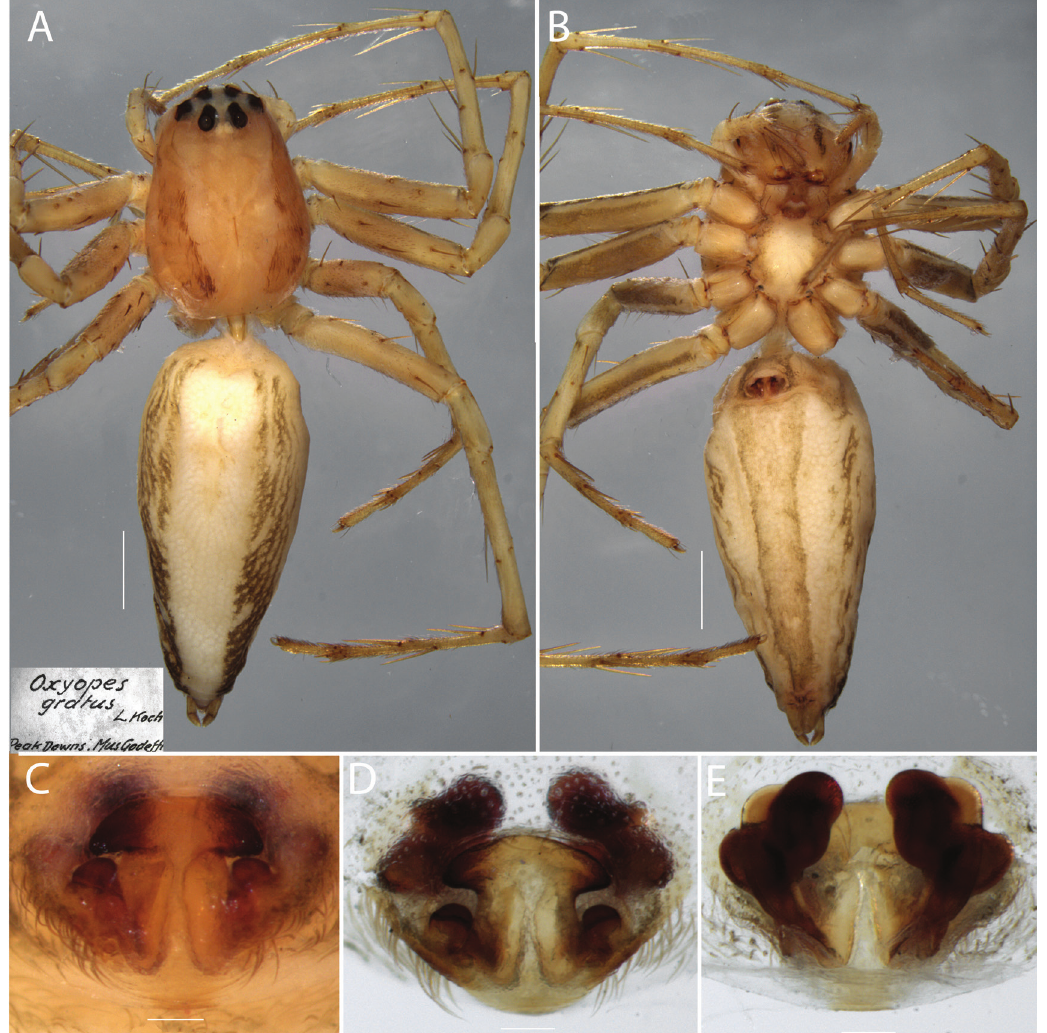
Figure 9. Oxyopes gratus L. Koch, 1878, female lectotype (ZMH- A0000009): A , habitus, dorsal view; B , habitus, ventral view; C , epigyne, ventral view; D, epigyne, ventral view, cleared; E , epigyne, dorsal view, cleared. Scale bars: habitus 1.0 mm, epigyne 0.1